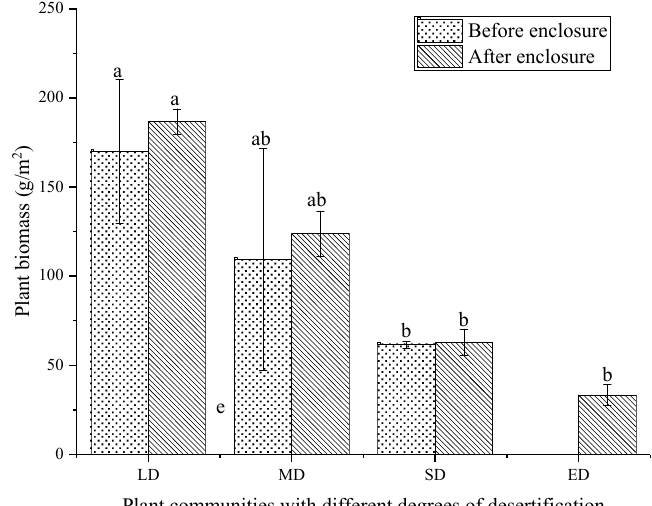
Figure 6. Aboveground biomass of different desertified grasslands. LD: light desertified grassland; MD: moderate desertified grassland; SD: severe desertified grassland; and ED: extreme desertified grassland. Data with different letters in the same column indicate significant differences at the 0.05 level.